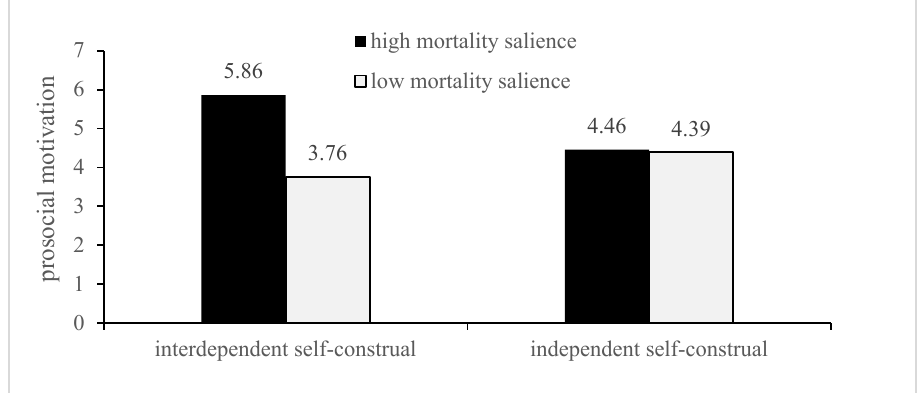
Figure 3. Moderating effect of self-construal type on the effect of mortality salience on prosocial motivation.